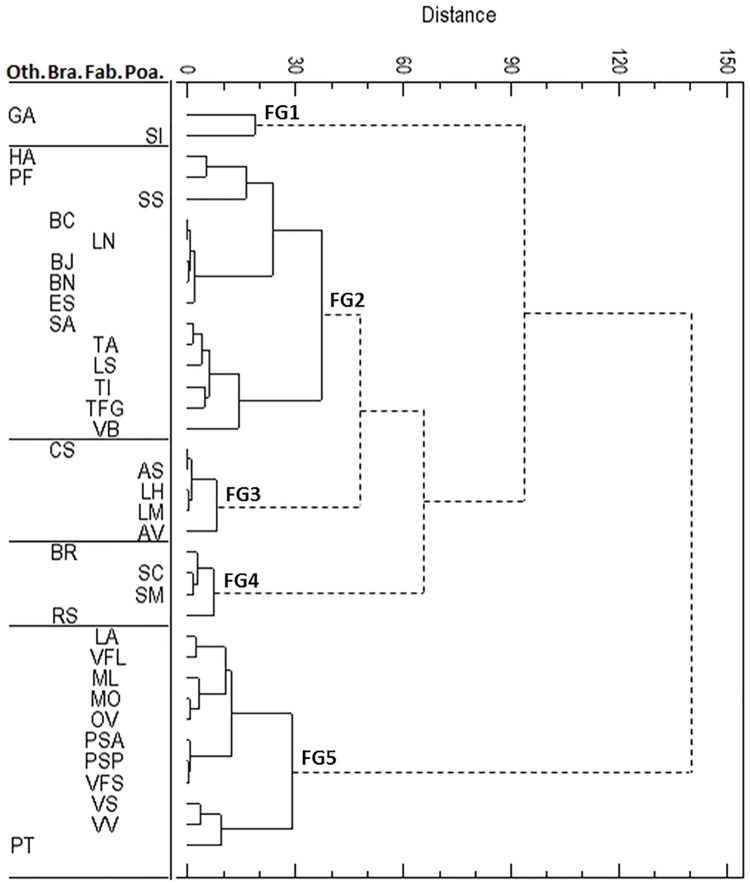
Hierarchical classification based on cardinal temperatures (T0, Tmax and Topt) and base water potential estimated on 36 cover crops using the Ward method (P<0.05).Solid lines represent distances between species of each of five functional groups (FG), and dashed lines represent distances between FGs. See Table 1 for the definition of species abbreviations; ‘Bra.’ is ‘Brassicaceae’, ‘Fab.’ is ‘Fabaceae’, ‘Poa.’ is ‘Poaceae’ and ‘Oth.’ is ‘Other families’.